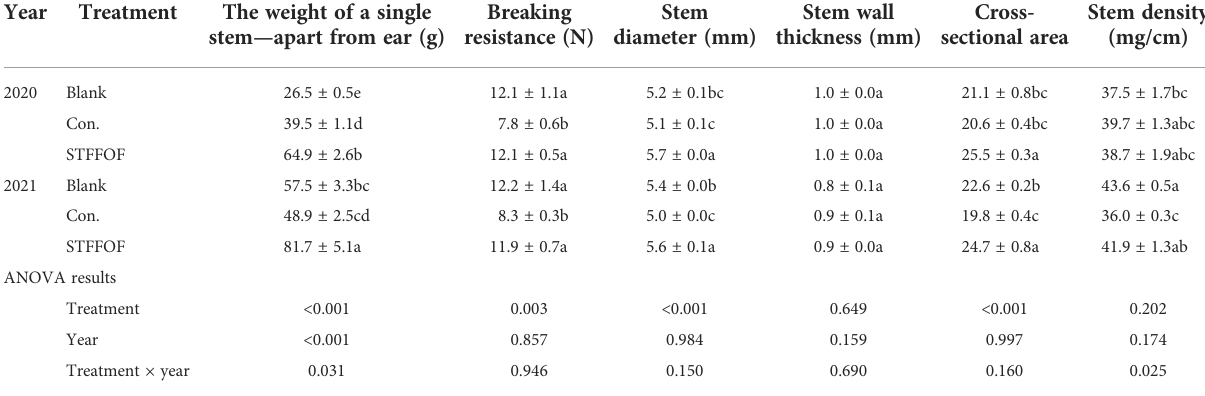
TABLE 3 Effects of soil-testing formula fertilization using organic fertilizer for 11 years on the physical structure of rice stem. Year Treatment The weight of a single stem — apart from ear